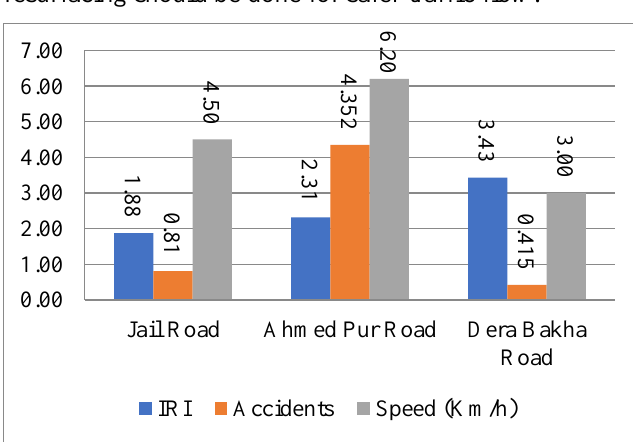
Fig. 10. Bar chart comparing iri, accident data (1/1000 scale) and speed (1/10